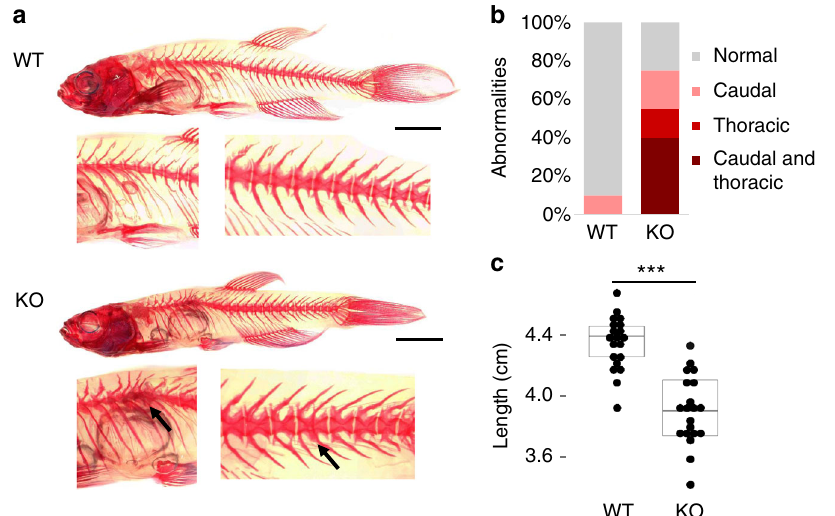
Fig. 4 Skeletal abnormalities and growth de fi cit in slc39a8 − / − zebra fi sh. a Thoracic and caudal vertebral malformations causing mild spinal curvature in slc39a8 − / − zebra fi sh (bottom) compared to WT (top) stained with alizarin red. Magni fi ed images show vertebral fusions in KO fi sh. Scale bar 5 mm. b slc39a8 − / − zebra fi sh have more spinal abnormalities than WT fi sh. c Reduced length of slc39a8 − / − zebra fi sh ( N = 20) compared to wild-type ( N = 20) at 9 mpf *** p < 10 − 6 , t -test. Lines are mean, fi rst and third quartiles